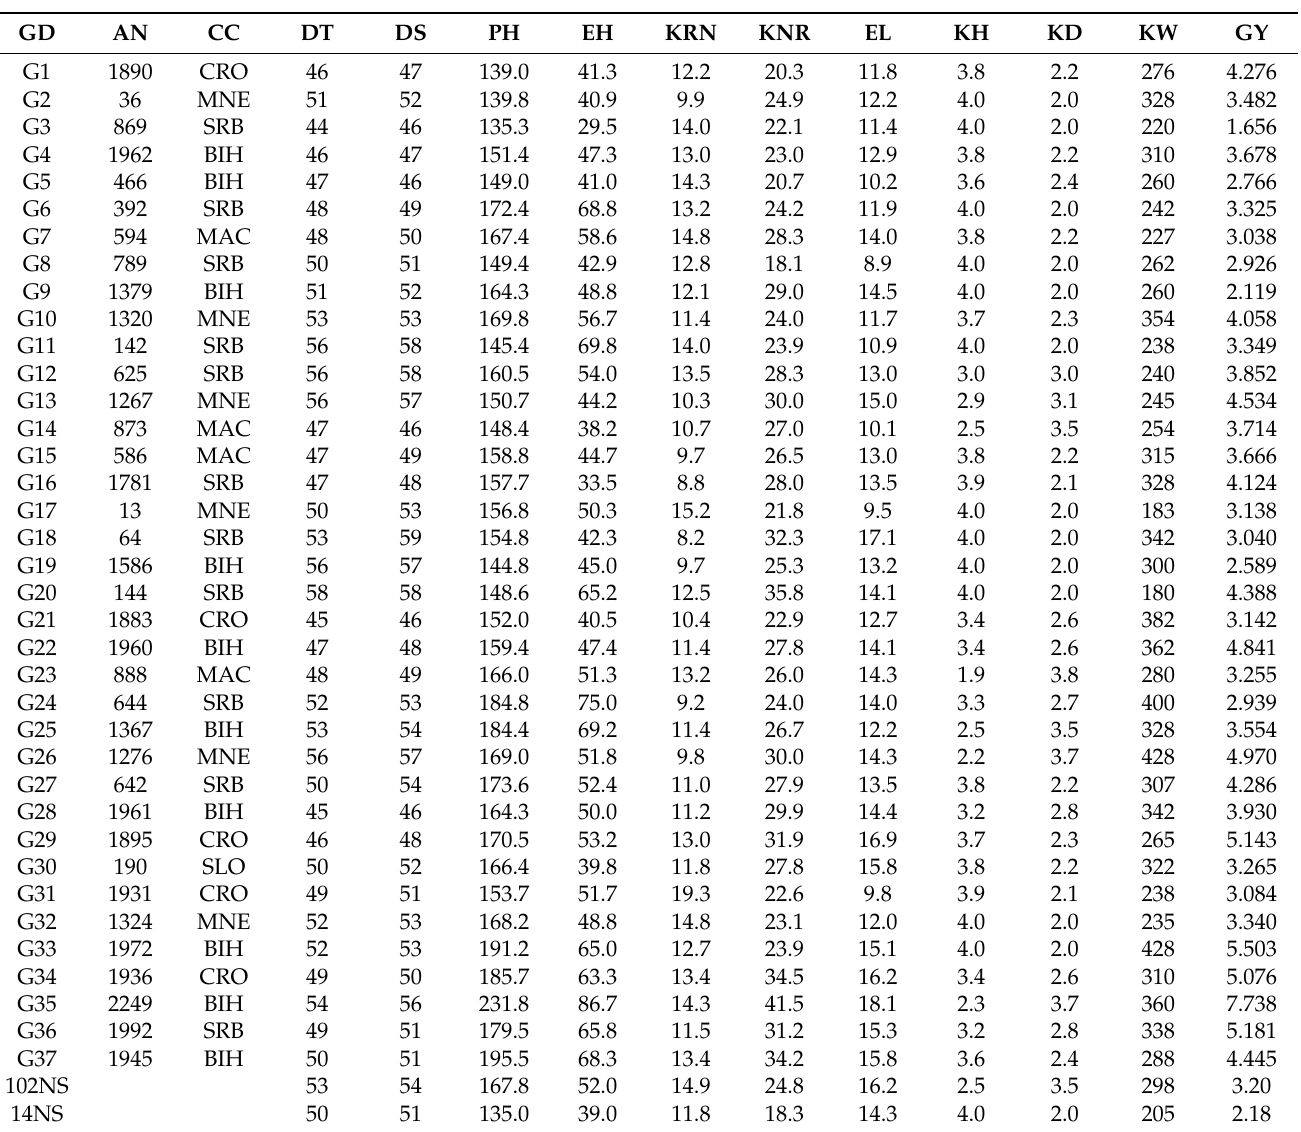
Table 1. Passport and morphological data of the evaluated maize landraces and testers